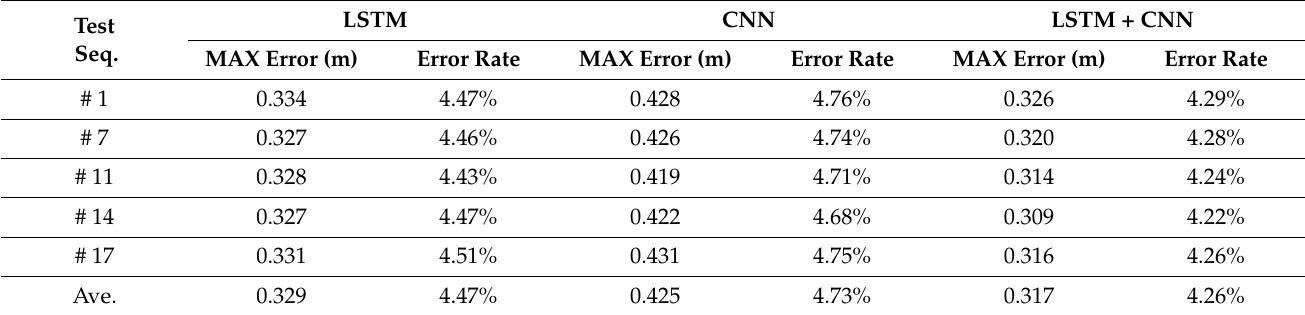
Table 4. The performance of the different neural networks.